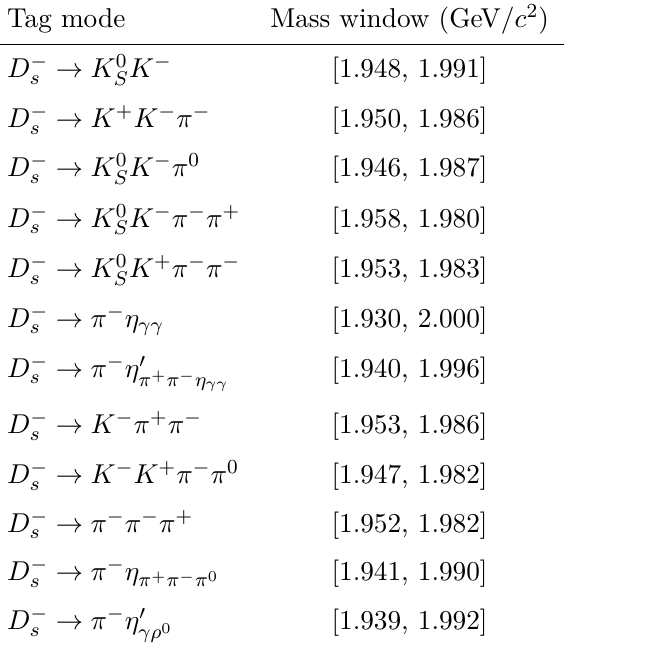
mass ( M ) for various tag modes, where the η and η 0 tag s